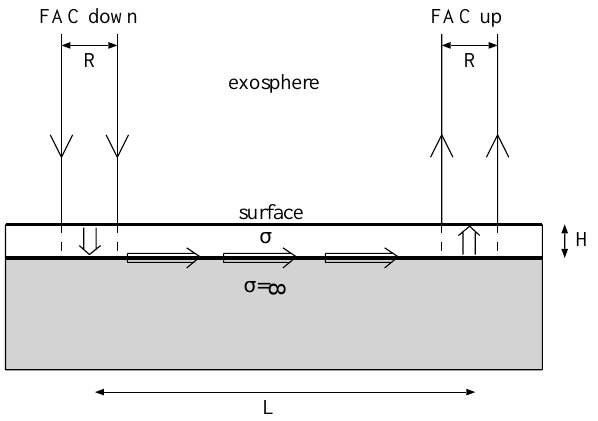
Fig. 1. A schematic 2-D two-layer model for FAC closure. The FAC flows into the surface on the left, moves down across a resistive surface layer (white, conductivity σ ) to an ideal conductor surface (gray), where it flows horizontally until it moves up on the right through the resistive layer again and emanates from the surface as an upward FAC.